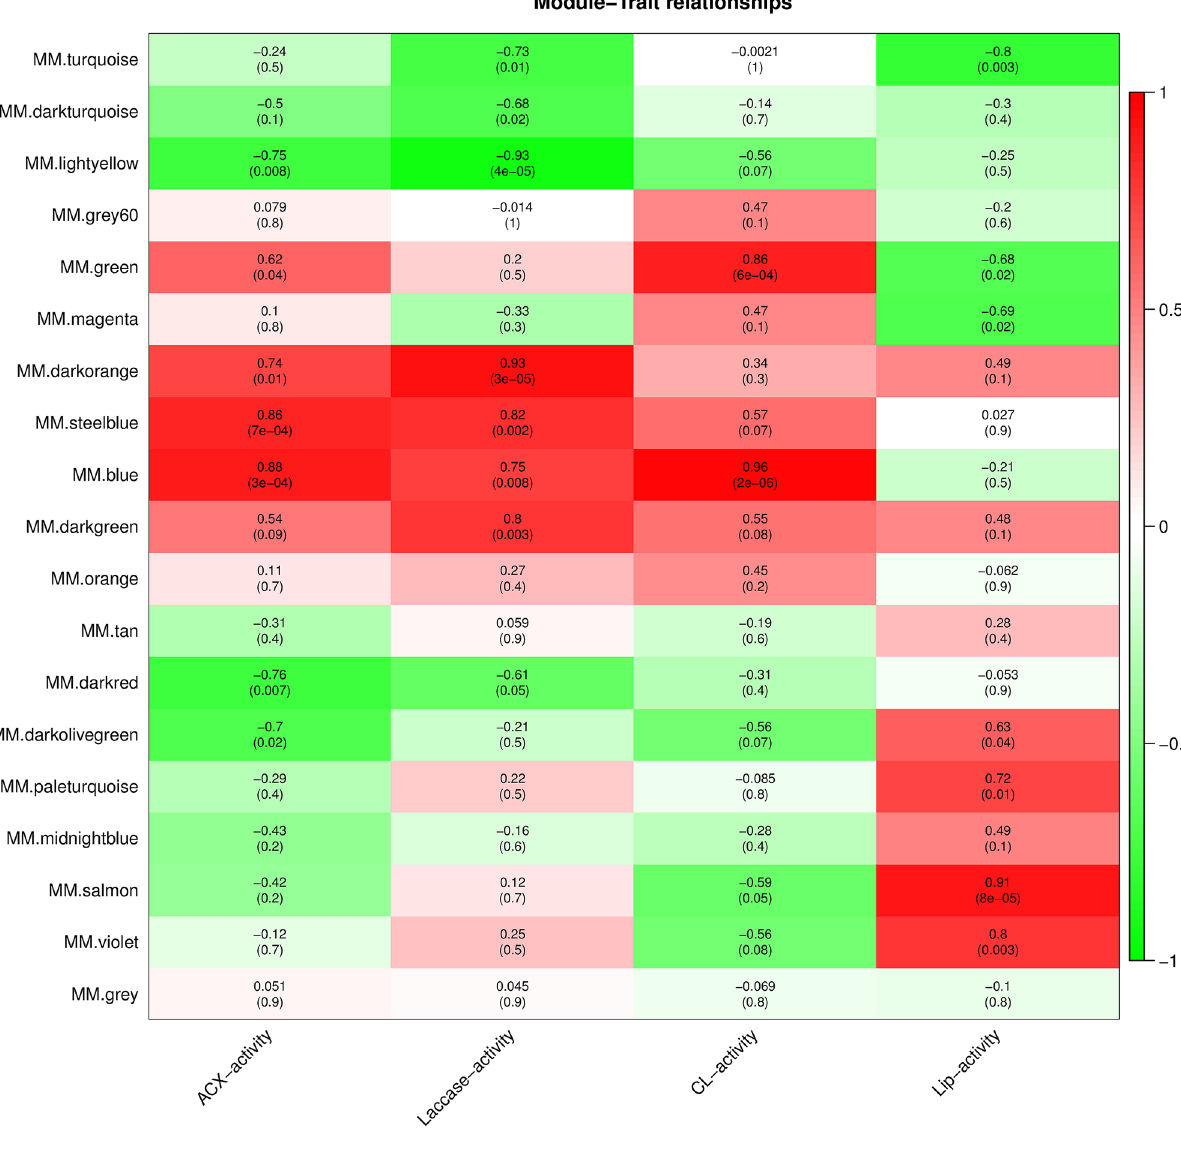
Figure 5. Association analysis of gene co-expression network modules with physiological and biochemical traits. The horizontal axis represents different characteristics, and the vertical axis represents each module. The red lattice represents a positive correlation between the physiological traits with the module, while the green lattice represents a negative